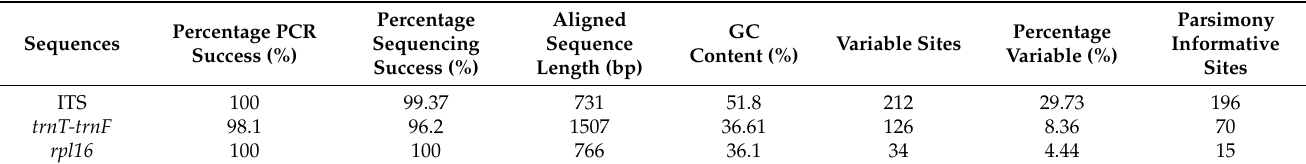
Table 1. Characteristics of the DNA barcode sequence and success rate of PCR amplification and